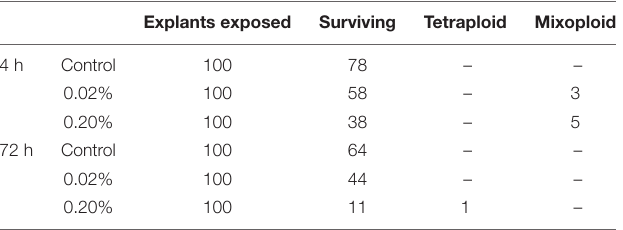
TABLE 1 | Survival rate and ploidal level of Lippia alba treated with colchicine at different concentrations and exposure times. Explants exposed Surviving